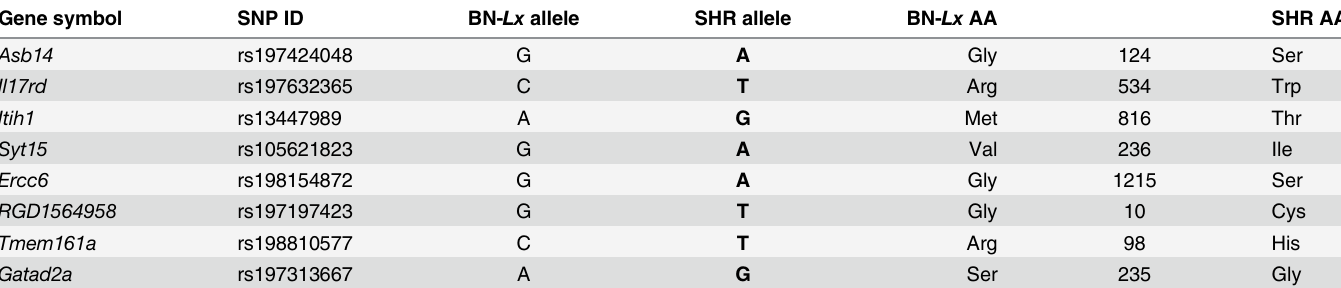
Table 2. Gene variants within the SHR.BN16 differential segment predicted to be probably or possibly